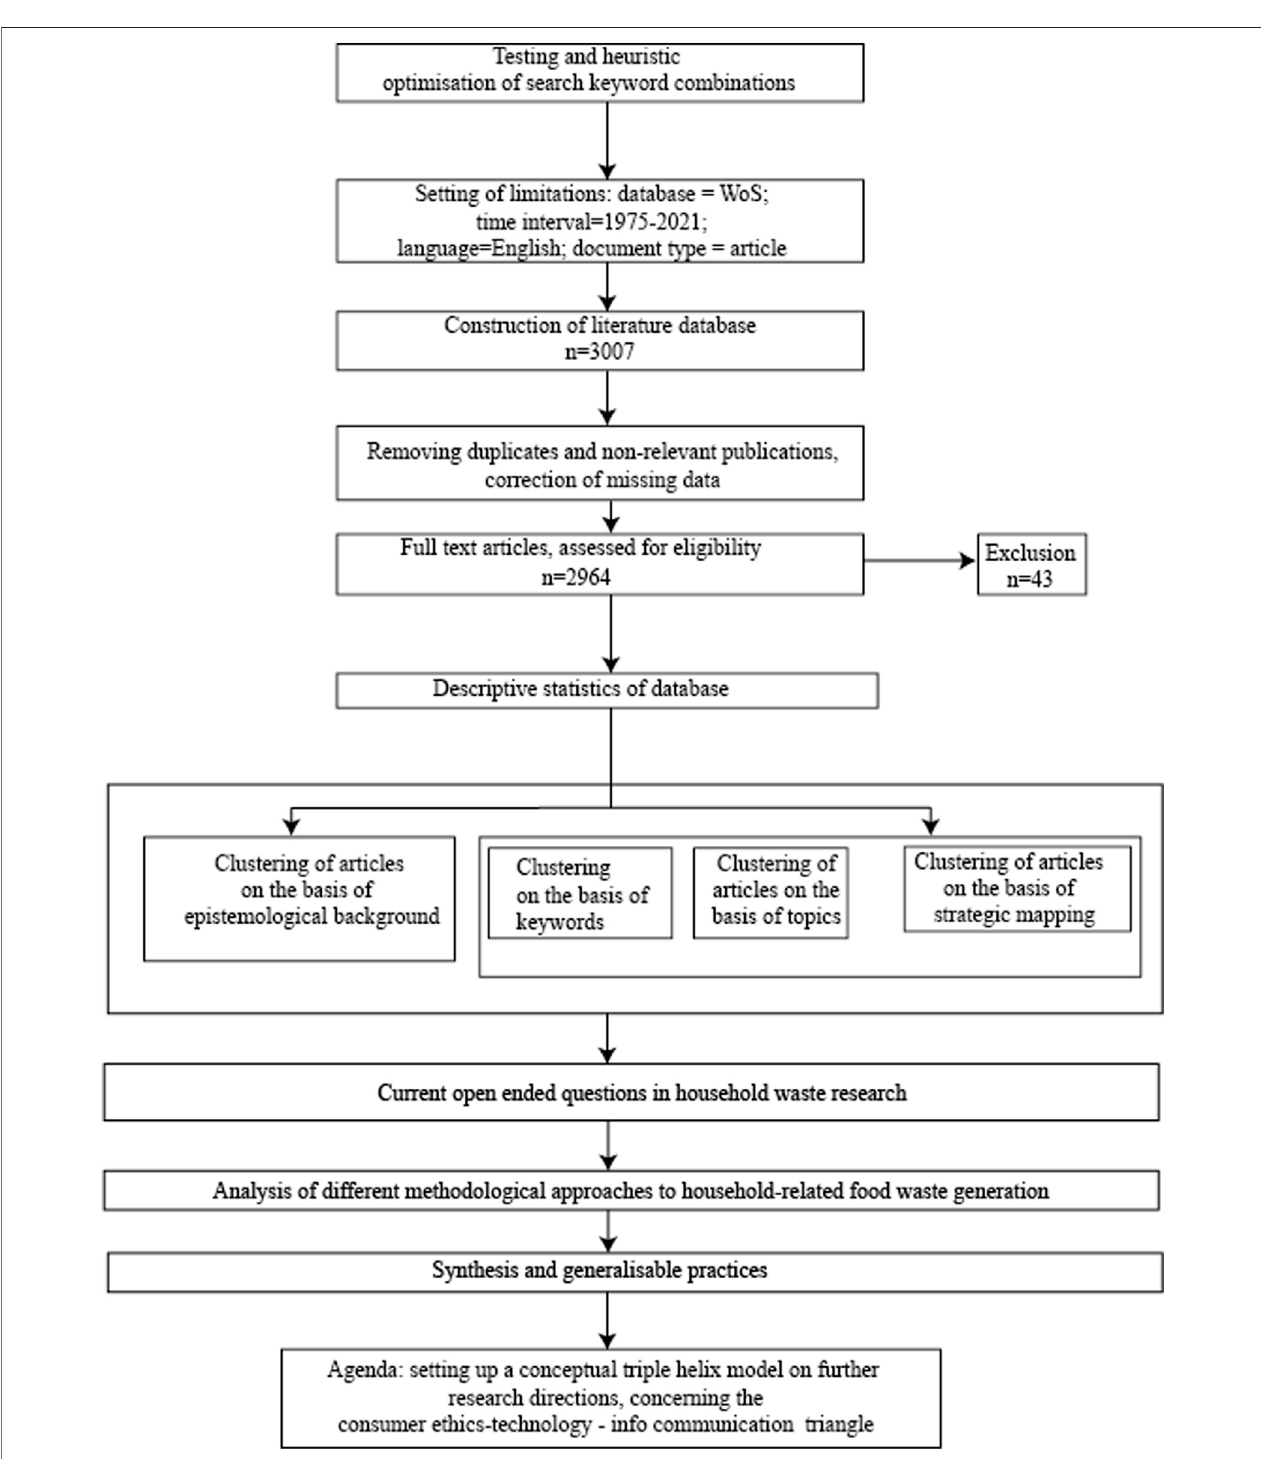
FIGURE 2 | Structure of the